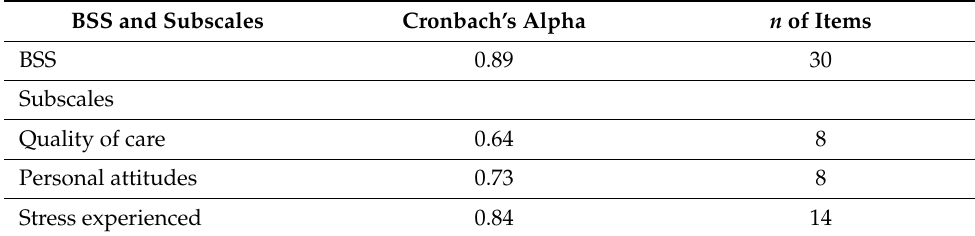
Table 2. Internal consistency of the BSS and